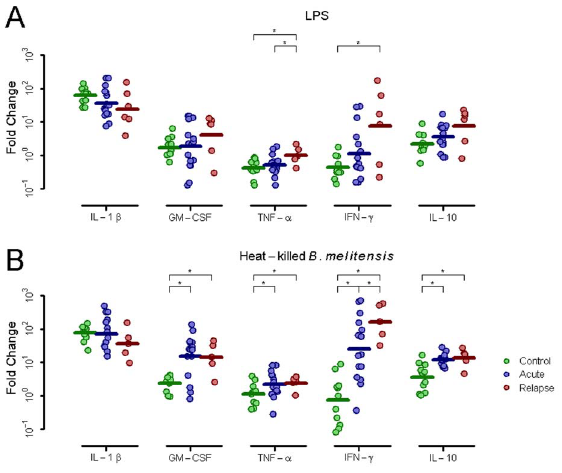
Figure 2. PBMC cytokine gene expression after stimulation. Fold change of gene expression for IL-1 b , GM-CSF, TNF- a , IFN- c and IL- 10 in PBMCs from control donors or acute or relapse brucellosis patients after stimulation with (A) LPS (B) Heat-killed B. melitensis or (C) R848 (asterisk indicates p # 0.05).